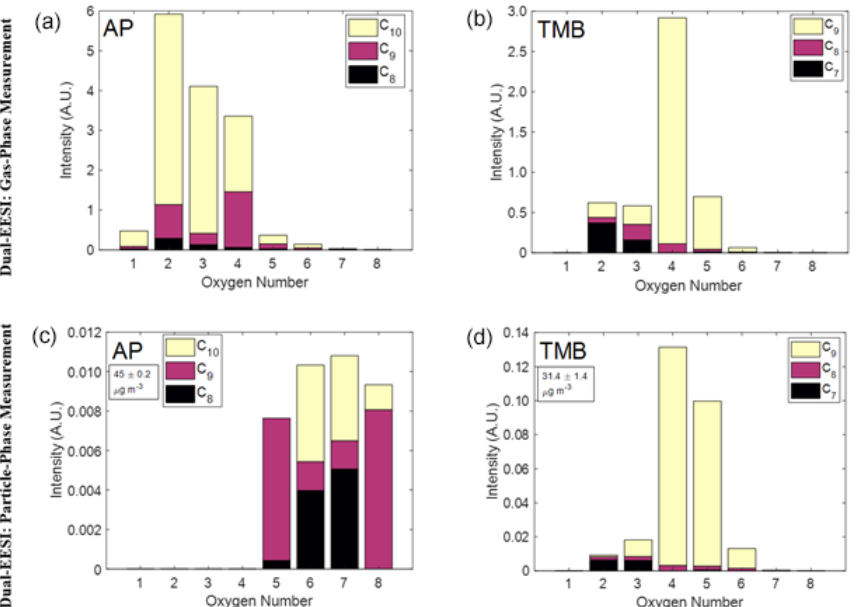
Figure 5. Measurement of gas- and particle-phase oxidation product mixtures generated inside a flow tube reactor using the Dual-EESI. (a, c) Gas-phase oxidation products (a) and SOA (c) from AP ozonolysis for C 8 − 10 H 12 − 16 O 1 − 8 with a total number of 73 species. (b, d) Gas-phase oxidation products (b) and (d) SOA from TMB oxidation with OH for C 7 − 9 H 8 − 16 O 2 − 8 with a total number of 32 species (see Table S3). Corrections for particle transmission efficiencies were not applied here, which might cause an uncertainty of up to 15%, as discussed in Sect. 3.2. The arbitrary unit (A.U.) denotes the quantity of the ion intensity after normalization to the most abundant ES ion [ NaI + Na ] + which was applied to the gas- and particle-phase